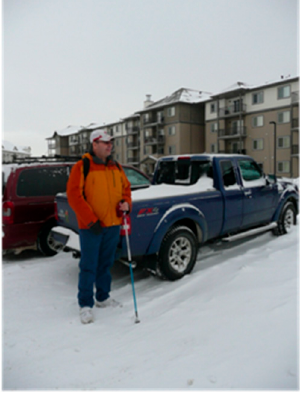
Figure 8. Group mentoring: Driving is possible.